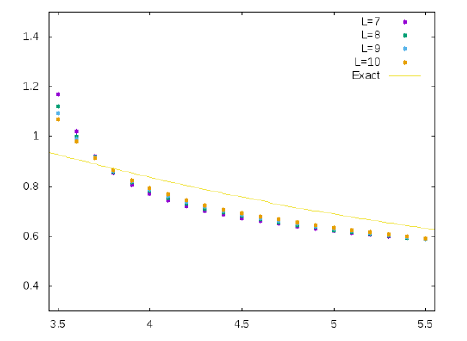
Figure 10 . The critical exponent plotted vs. k , using the values r = 2 : 1 and j = 1 in the unblob